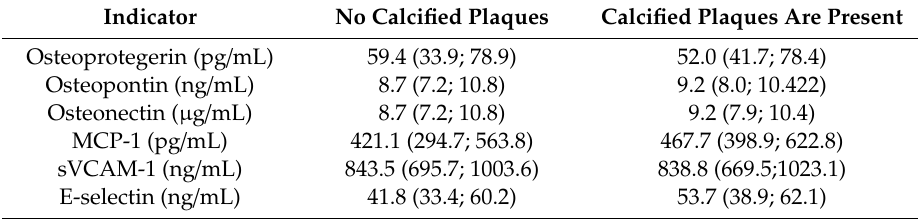
Table 5. Biochemical indicators of calcification and of endothelial dysfunction in the blood of males with coronary atherosclerosis, depending on the presence of calcification deposits in atherosclerotic plaques (Me (25%;